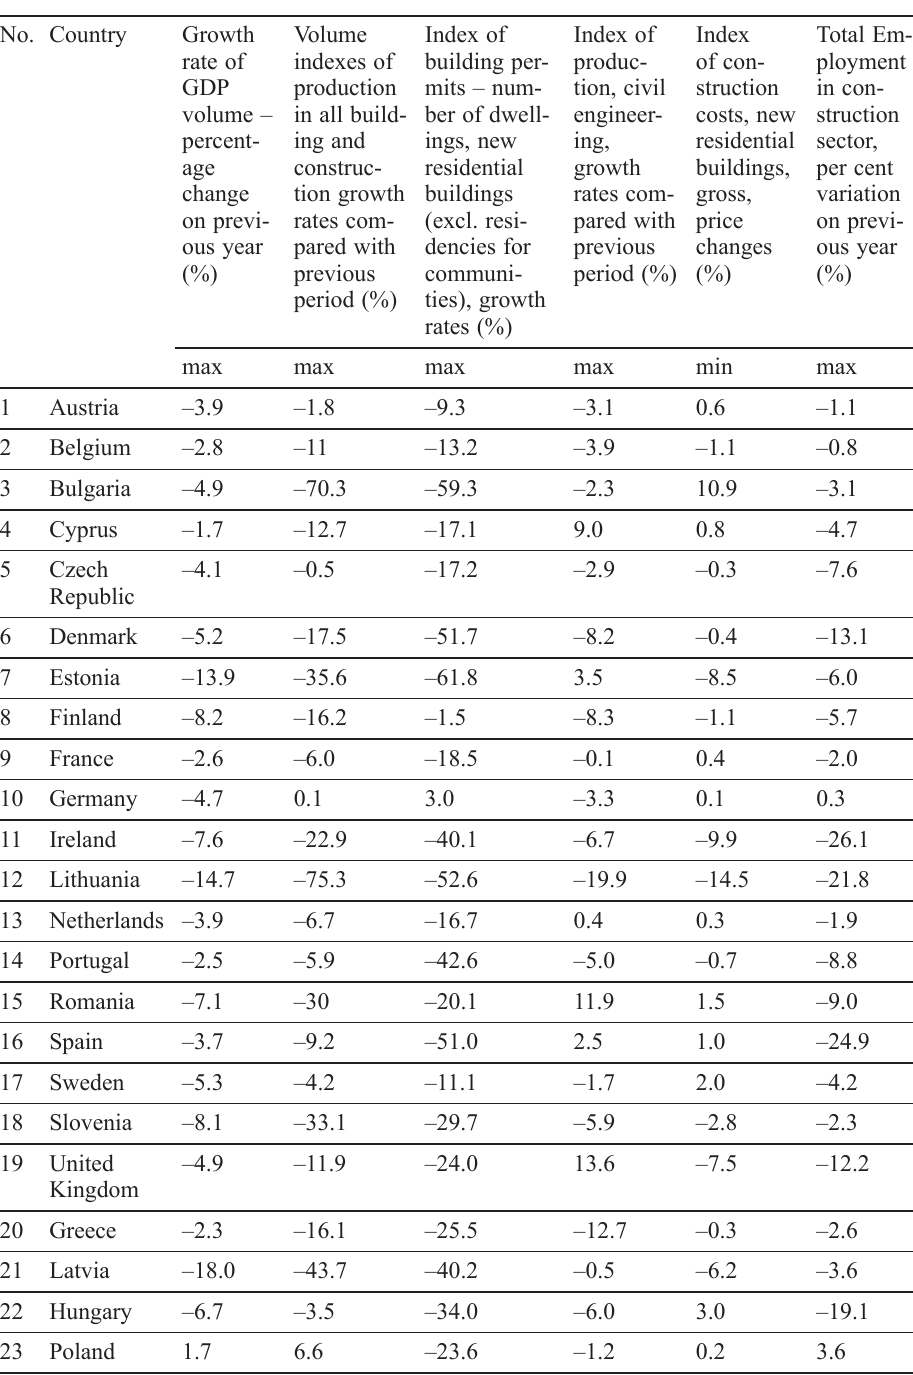
Table 1. Criteria for evaluation of European states and statistic